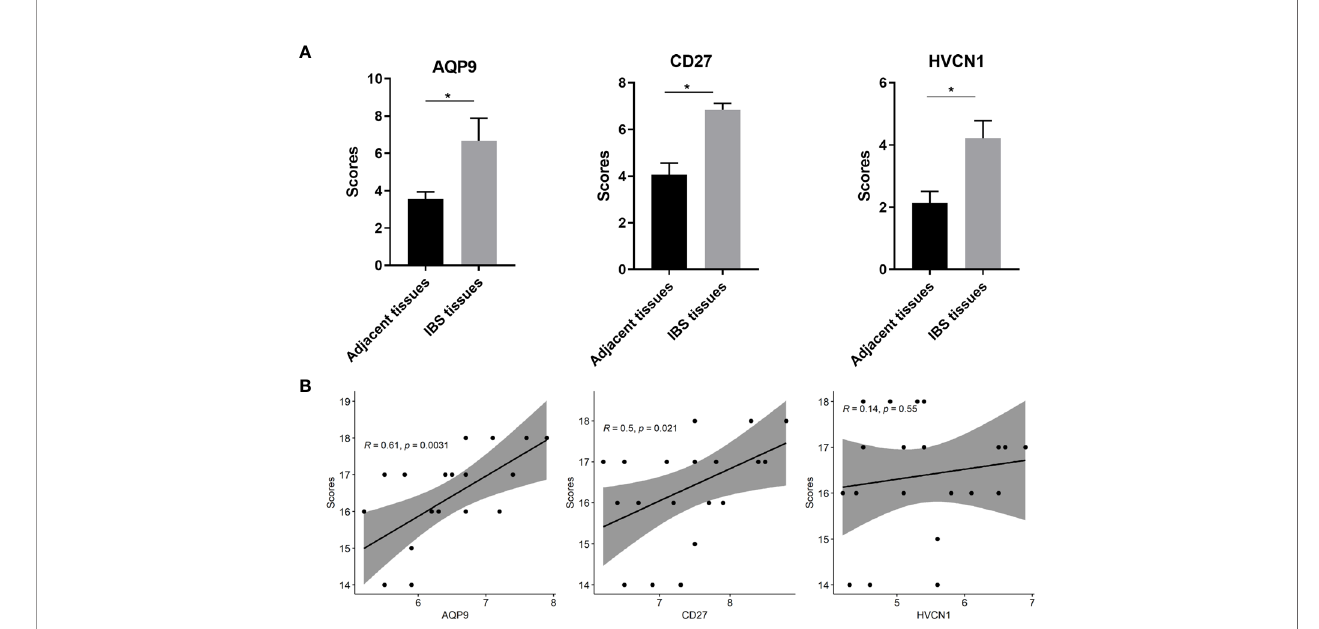
FIGURE 7 | (A) Comparison of IHC intensity score between adjacent normal intestinal tissues and CD tissues regarding the AQP9 , CD27 and HVCN1 ; (B) Correlation analysis between the CDAI scores and the expression of AQP9 , CD27 and HVCN1 in CD tissues. IHC, Immunohistochemical; CDAI, Crohn ’ s Disease Activity Index, *indicated p-value <